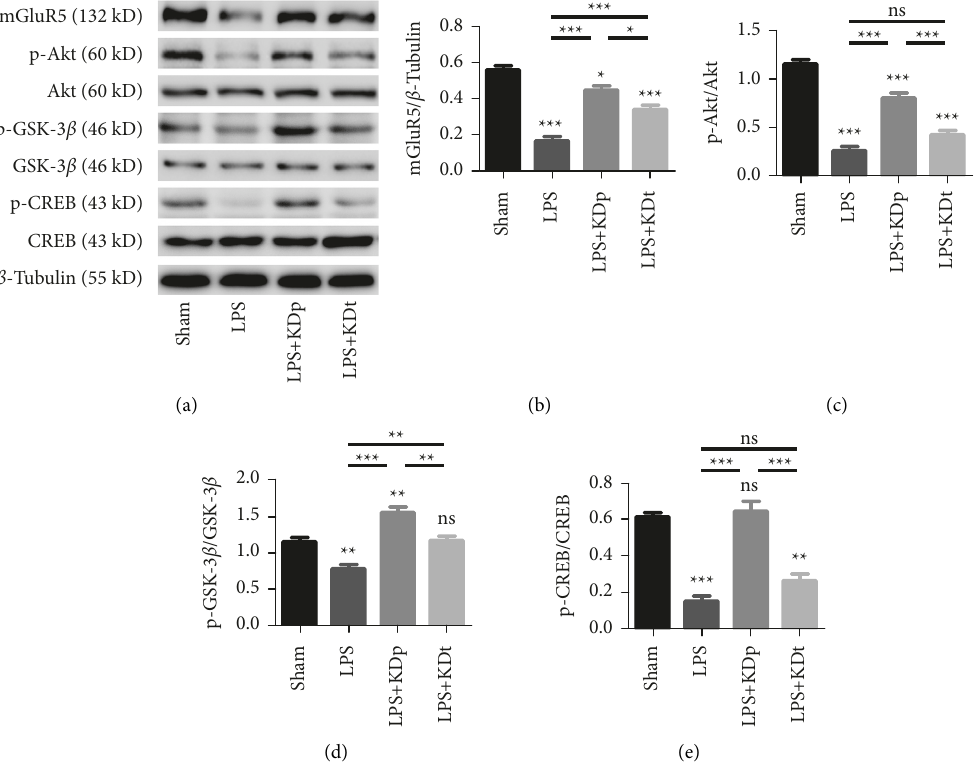
Figure 6: The effects of LPS and KD on the expression of mGluR5, p-Akt, p-GSK-3 β and p-CREB in SN. The expression of mGluR5 (a, b), and phosphorylation of Akt (a, c), GSK-3 β (a, d) and CREB (a, e) were compared among multiple groups. Data were presented as the mean ± SEM. ∗∗∗ P < 0 . 001; ∗∗ P < 0 . 01; ∗ P < 0 . 05; LPS, lipopolysaccharide; KDp, preventive intervention with KD prior to the PD onset; KDt, therapeutic intervention with KD after the PD